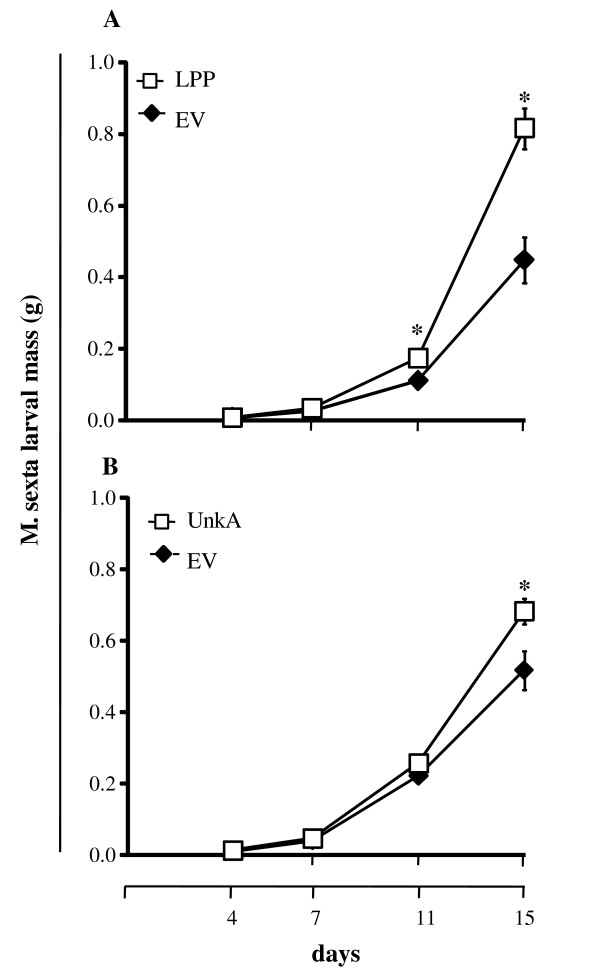
M. sexta larval performance on LPP- and UnkA-silenced plants. N. attenuata plants were silenced in the expression of LPP and UnkA by VIGS. Plants transformed with the empty vector (EV) were used as control. A, Mean (± SE) of M. sexta larval mass after 4, 7, 11 and 15 days of feeding on EV and LPP-silenced plants (n = 32 for each genotype). Statistical analysis was performed by repeated-measurement ANOVA (F1,54 = 12.79, P < 0.01). B, Mean (± SE) of M. sexta larval mass after 4, 7, 11 and 15 days of feeding on EV and UnkA-silenced plants (n = 32 for each genotype). Statistical analysis was performed by repeated-measurement ANOVA (F1,48 = 6.62, P < 0.05). In both cases asterisks represent significant differences between EV and the corresponding silenced line. Both experiments were conducted two times independently with identical results.